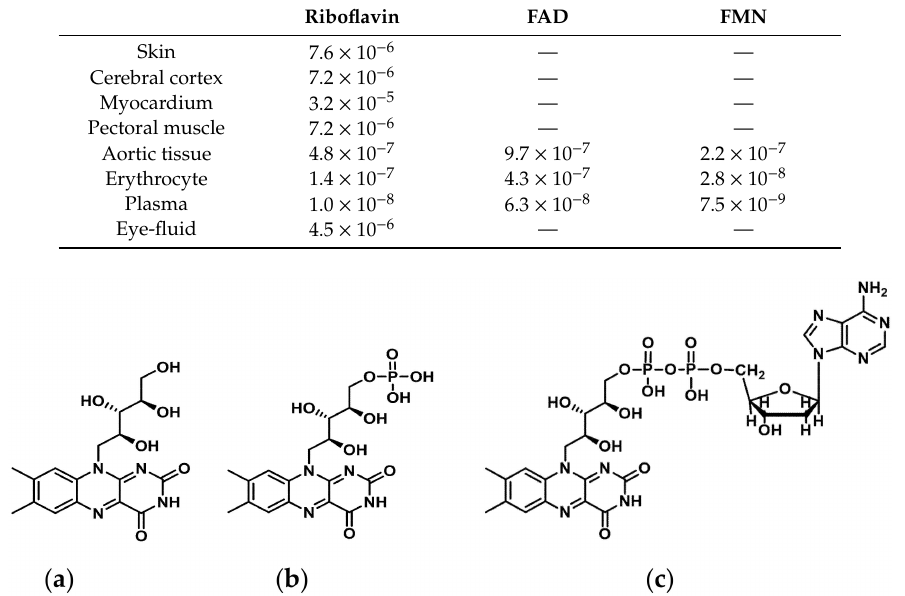
Figure 1. Structure of ( a ) Riboflavin (RF), ( b ) Flavin monophosphate (FMN), and ( c ) Flavin adenine dinucleotide (FAD). ChemDraw (PerkinElmer Informatics, Inc. MA, USA) Both FMN and FAD play a key role as cofactors in energy metabolism and are required for co- enzyme function in numerous oxidation and reduction reactions in all aerobic forms of life. RF has been used in dietary supplements and for inflammatory disease treatments such as angulus infectious, cheilitis, glossitis [7], sepsis [8,9], cataracts and migraine headaches [3] (Figure 2).